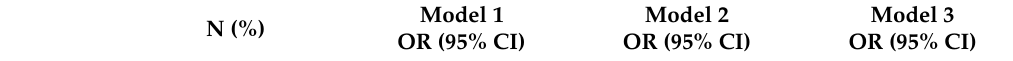
Model 2 OR (95% CI)